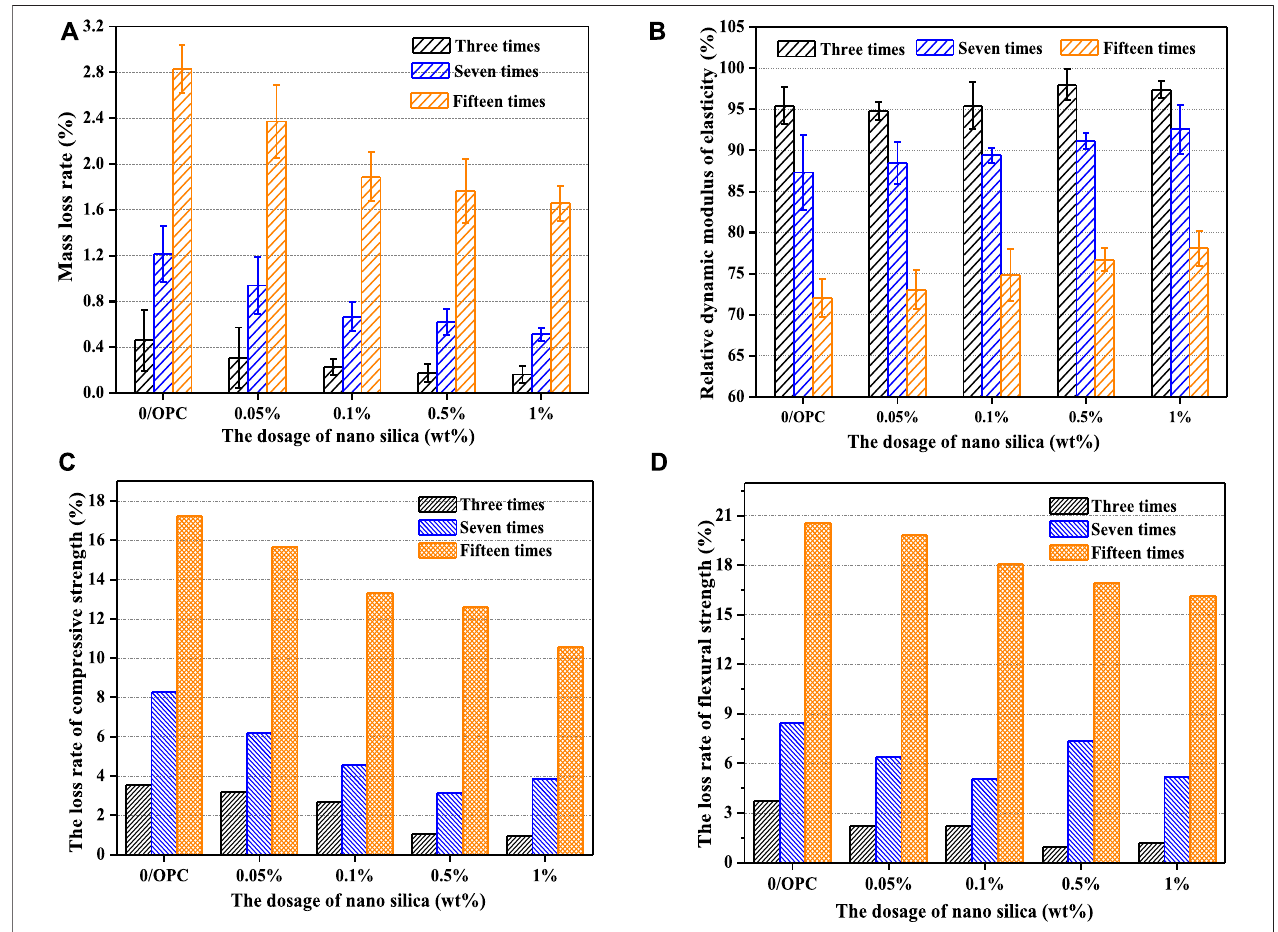
FIGURE 3 | (A) Mass loss rate, (B) Relative dynamic elastic modulus, (C) Loss rate of fl exural strength, and (D) Loss rate of compressive strength of nano SiO 2 modi fi ed concrete samples experienced F/T and W/D cycles in a 3 wt% of CaCl 2 solution.